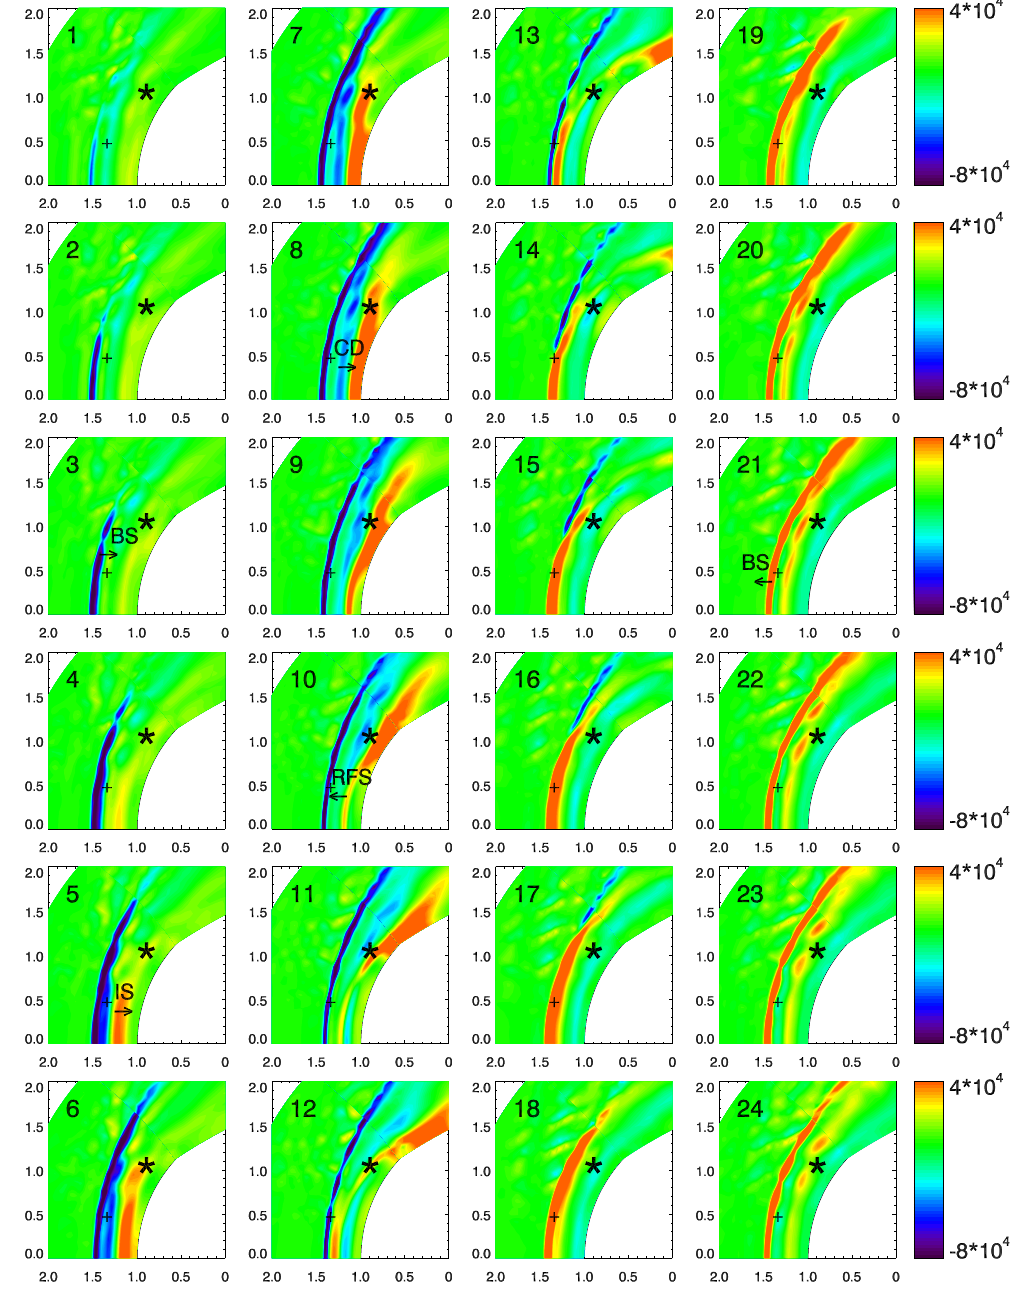
Fig. 11. Contours of 1T showing variations of temperature. The format is the same as that in Fig.